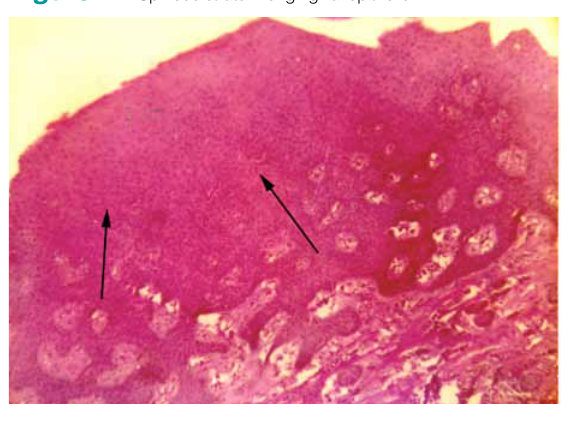
Figure 2 . Stratum corneum of gingival epithelium